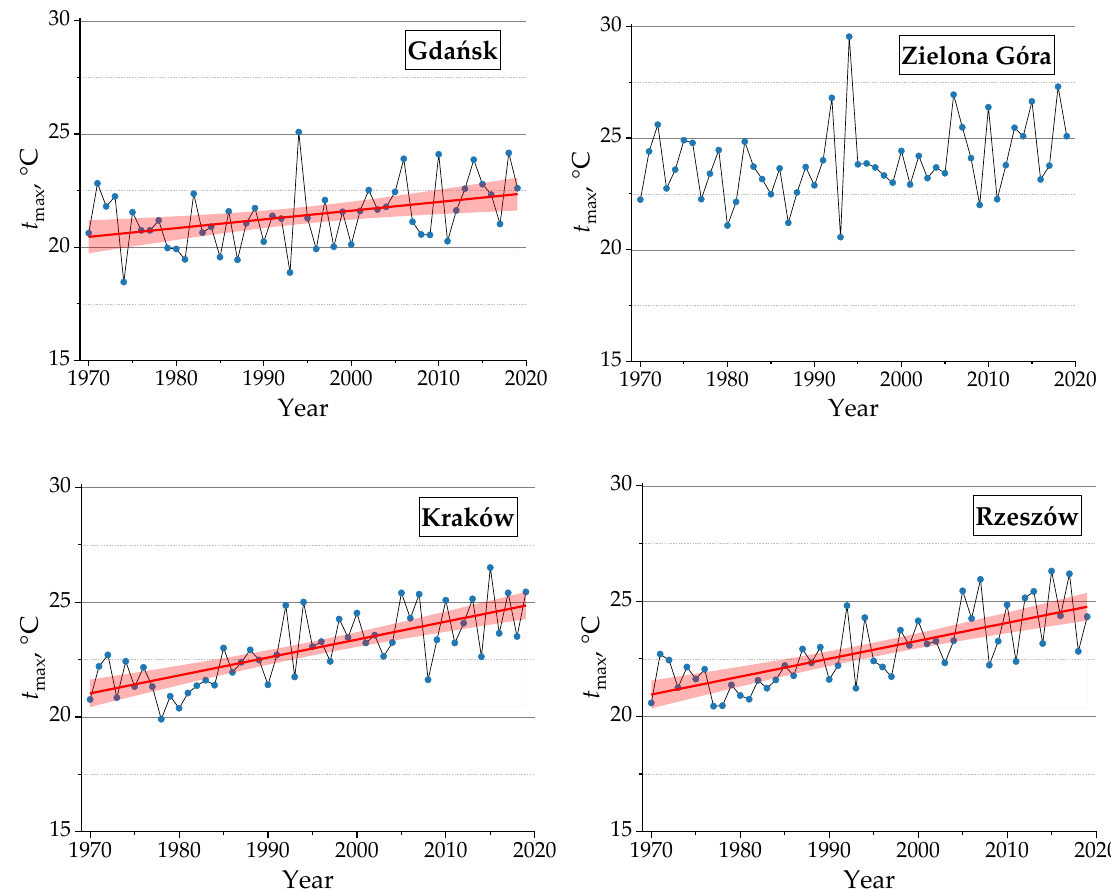
Figure 7. A set of the maximum five-day temperatures in Gdańsk , Zielona Góra , Kraków , and Rzeszów between 1970 and 2019.